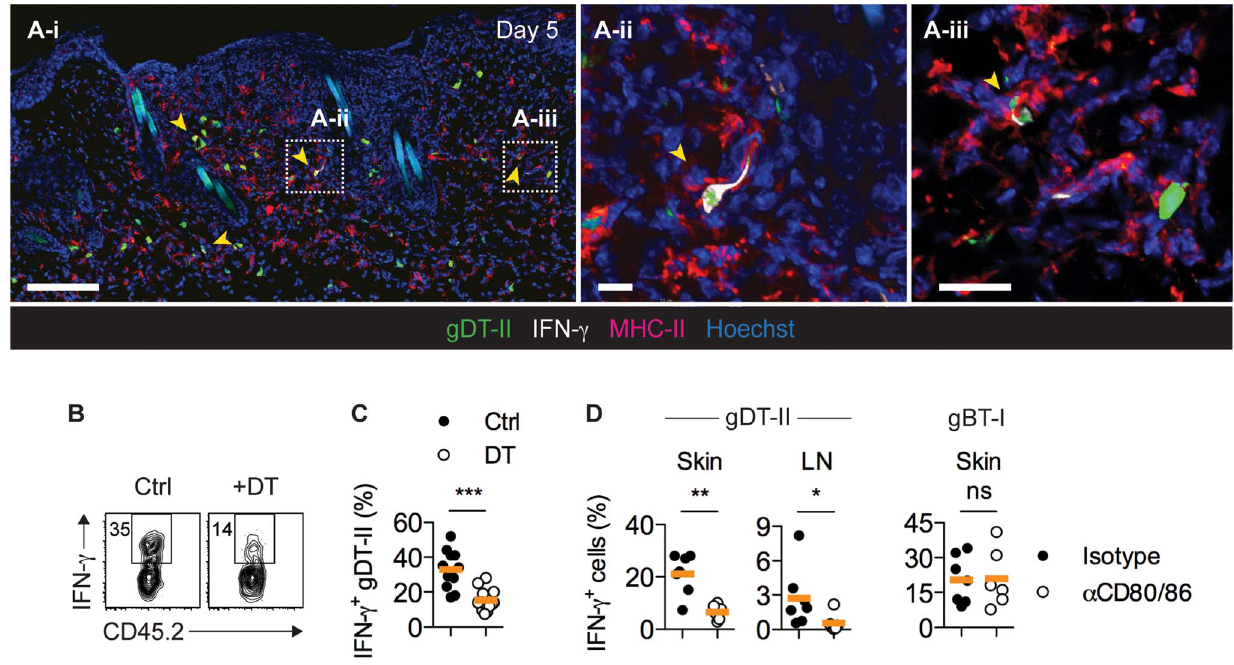
Figure 4. CD11c + DCs drive IFN- c production by CD4 + T EFF cells invivo . ( A ) Mice received GFP + gDT-II cells prior to HSV-1 skin infection. IFM analysis of skin 5 days post-infection after staining with anti-MHC-II and -IFN- c antibodies. Arrows indicate IFN- c + gDT-II cells. Scale bars: A-i , 100 m m; A-ii , 20 m m; A-iii , 20 m m. ( B , C ) CD11c.DTR mice received naı¨ve gDT-II cells prior to HSV-1 skin infection and 4 days post-infection were treated with diphtheria toxin (DT) or PBS (Ctrl). Analysis of IFN- c + gDT-II cells in skin (collagenase digestion). ***, P , 0.001 by Mann Whitney test; n =11–15 mice/ group from 3 experiments. ( D ) Wild-type mice received naı¨ve gDT-II or gBT-II cells prior to infection and 4 days post-infection were treated with anti- CD80/86 ( a CD80/86) or isotype control (Isotype) antibodies. Analysis of IFN- c + gDT-II cells in skin (collagenase digestion) and axillary LNs, and of IFN- c + gBT-I cells in epidermal sheets (dispase digestion) days 5 post-infection. *, P , 0.05; **, P , 0.01; ns, not significant by Mann Whitney test; n =6–7 mice/group from 2–3